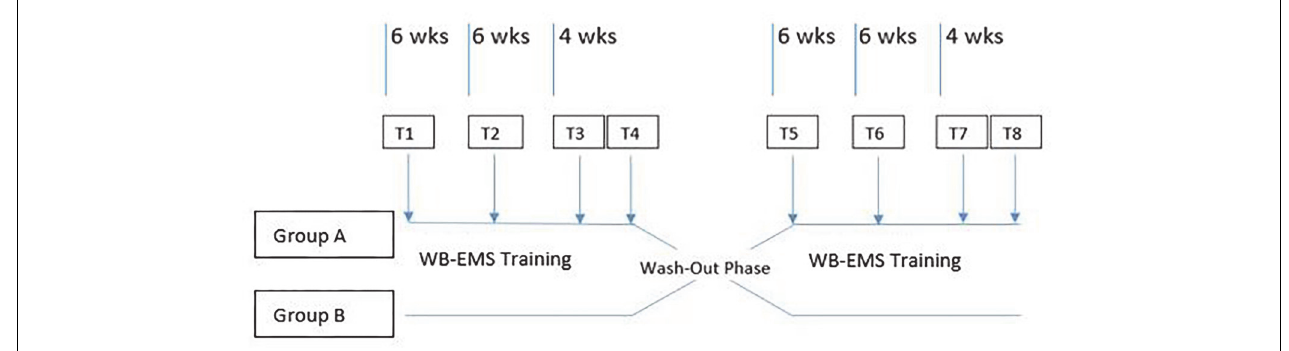
FIGURE 1 | Scheme of cross-over study course with consecutive wash-out phase between period 1 and period 2.